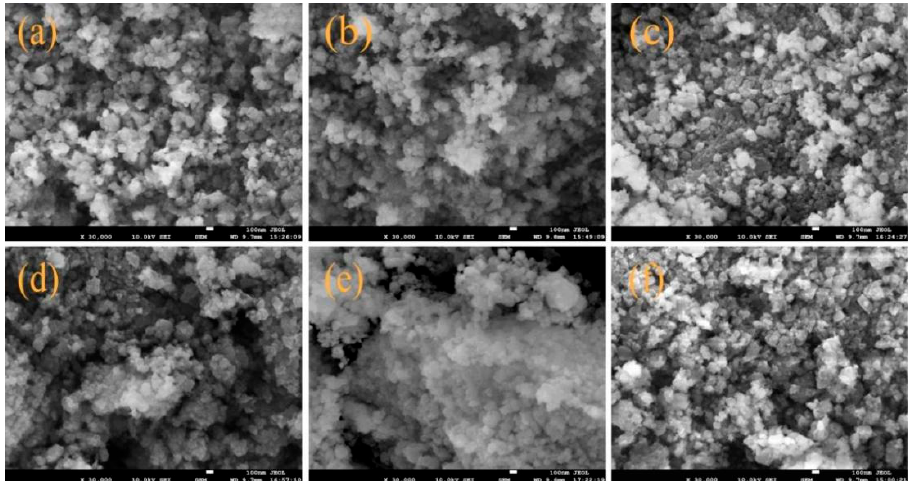
Figure 2. Scanning electron microscopy images of the catalysts with hydrogen pre-treatment. ( a ): HZSM-5; ( b ): Zr/HZSM-5; ( c ): Co/HZSM-5; ( d ): Mo/HZSM-5; ( e ): Ga/HZSM-5: ( f ): Zn/HZSM-5.